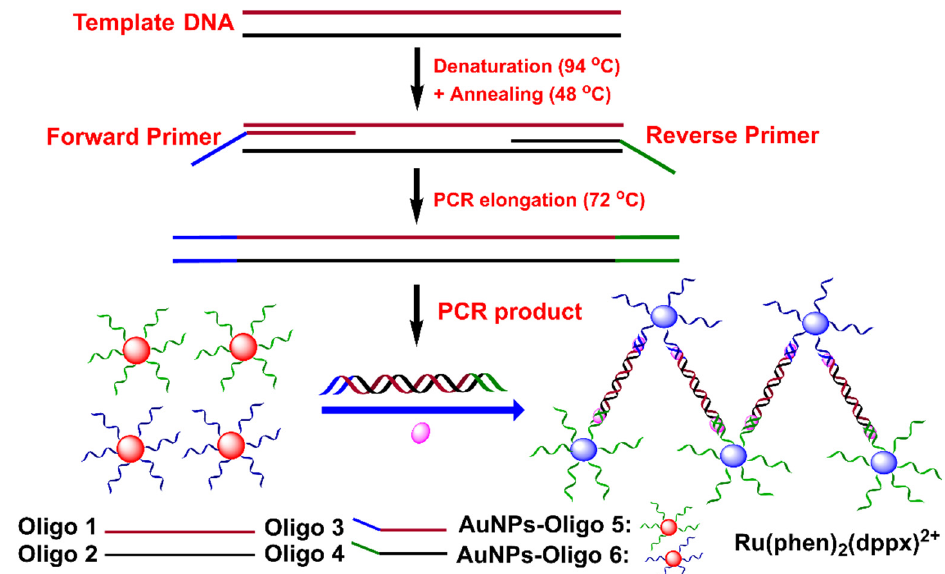
Figure 6. Schematic diagram of PCR product-mediated assembly of SNAs through triplex DNA formation for colorimetric detection of Escherichia coli . Adapted with permission from ref [74]. Copyright 2019 Elsevier.